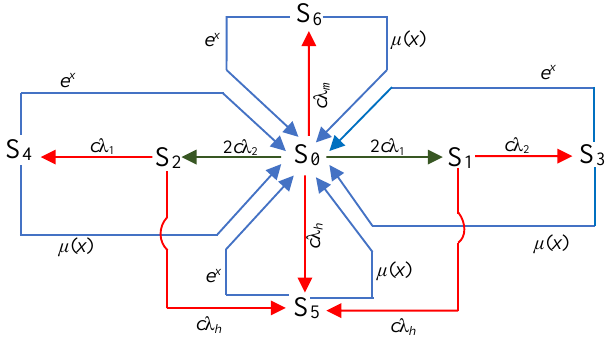
Figure 1. System state transition